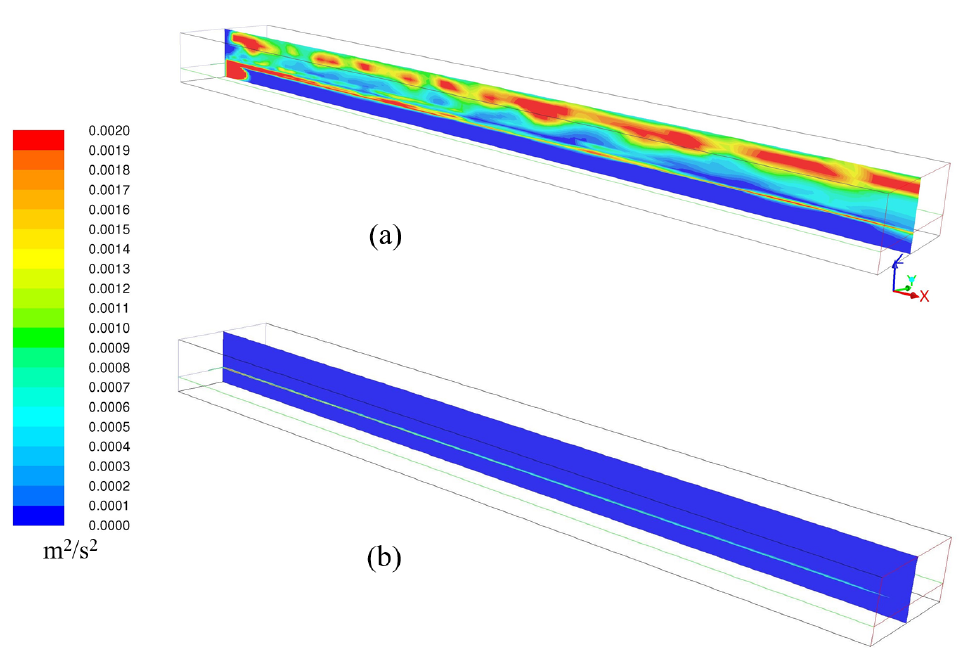
Figure 9. The field of kinetic turbulent energy in a vertical section at the middle of the computational domain: ( a ) for brine flow at a velocity of 0.2 m/s from a linear source of height 0.1 m and length 10 m over a period of 24 h and ( b ) for the same source of pure